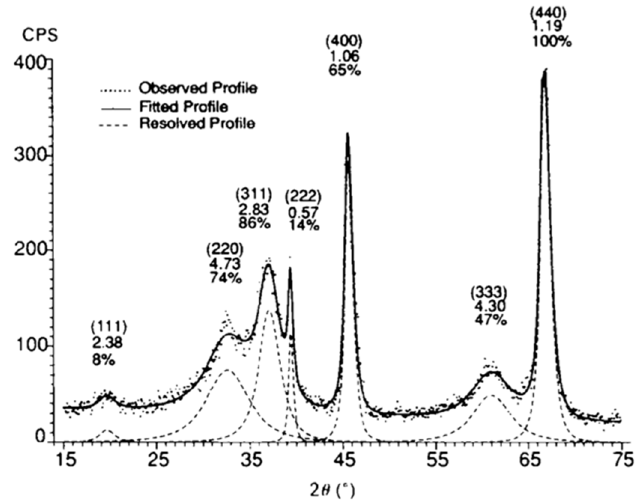
Figure 3. XRD powder pattern of γ -alumina. Values given above the peaks are hkl’s, FWHM and relative intensity. Figure reproduced from Zhou & Snyder (1991). Acta Cryst. B 47 , 617–630, https://doi.org/10.1107/S0108768191002719 with permission of the International Union of Crystal ‐ lography.